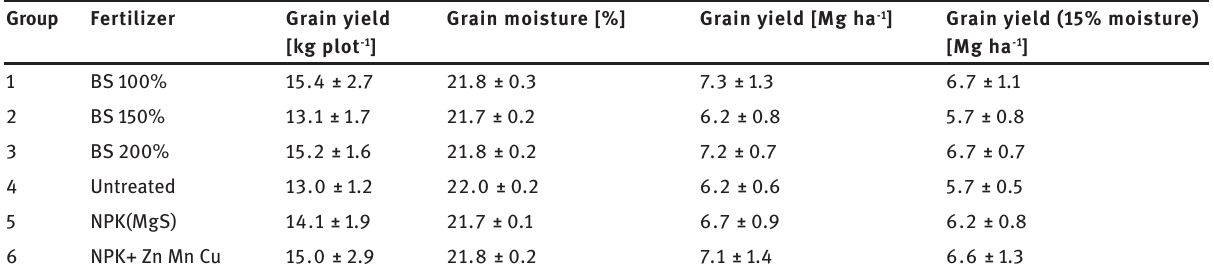
Table 4: Effect of fertilization on yield properties – grain yield [kg plot -1 , Mg ha -1 ], grain moisture [%]. Results with standard deviations. Group